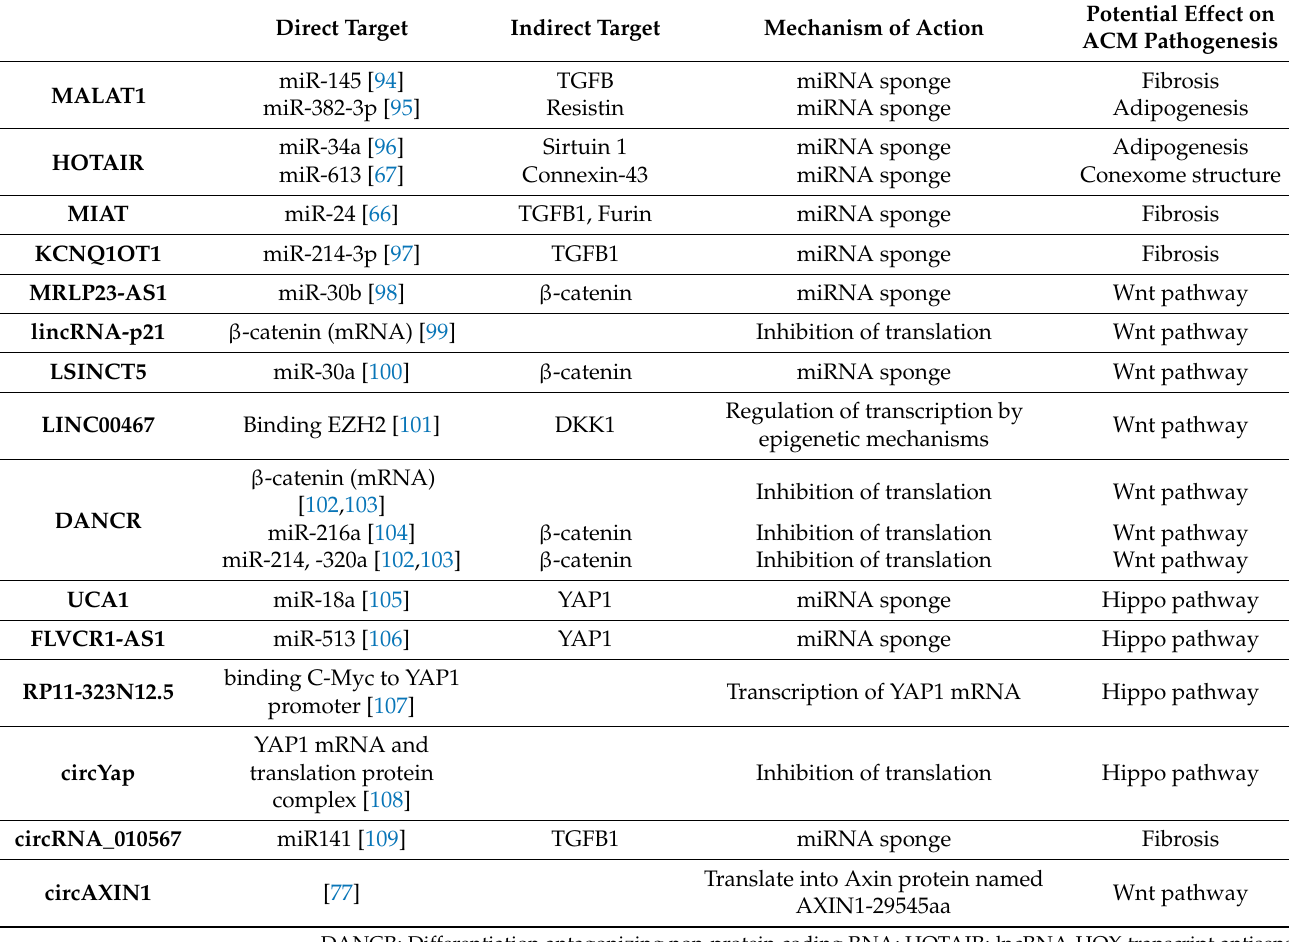
Table 4. Main competing endogenous RNAs (ceRNAs) studied in cancer research that regulate the most affected pathways involved in arrhythmogenic